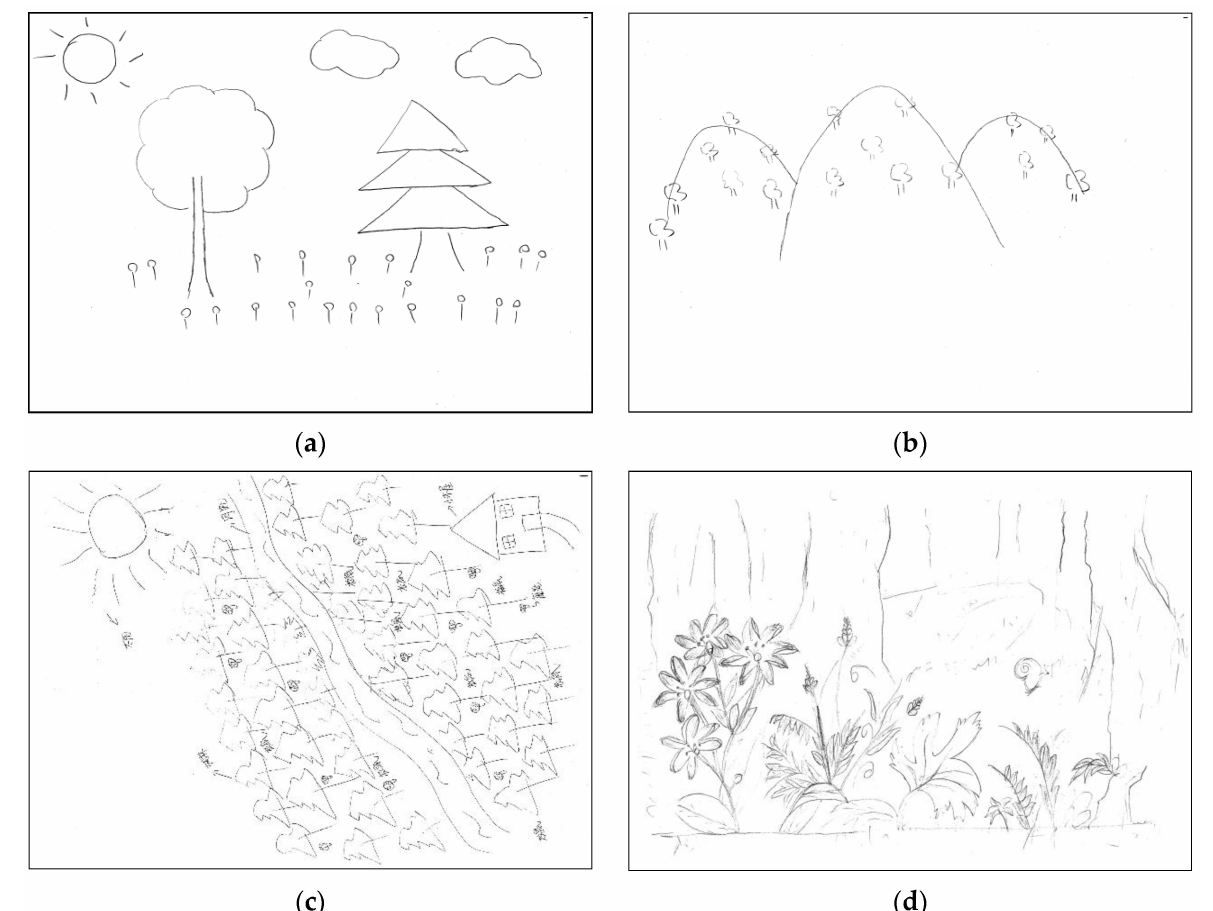
Figure 3. Classification of spatial views: ( a ) sideways view; ( b ) distant view; ( c ) bird’s-eye view; ( d ) close-up